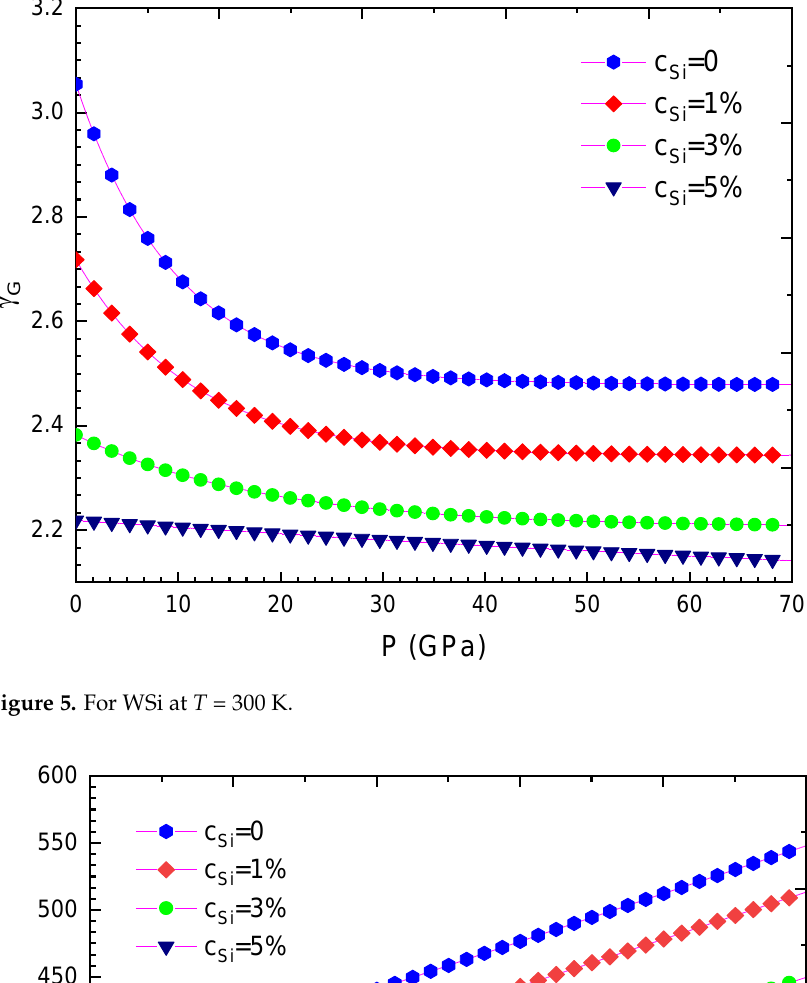
T for WSi at T = 300 D